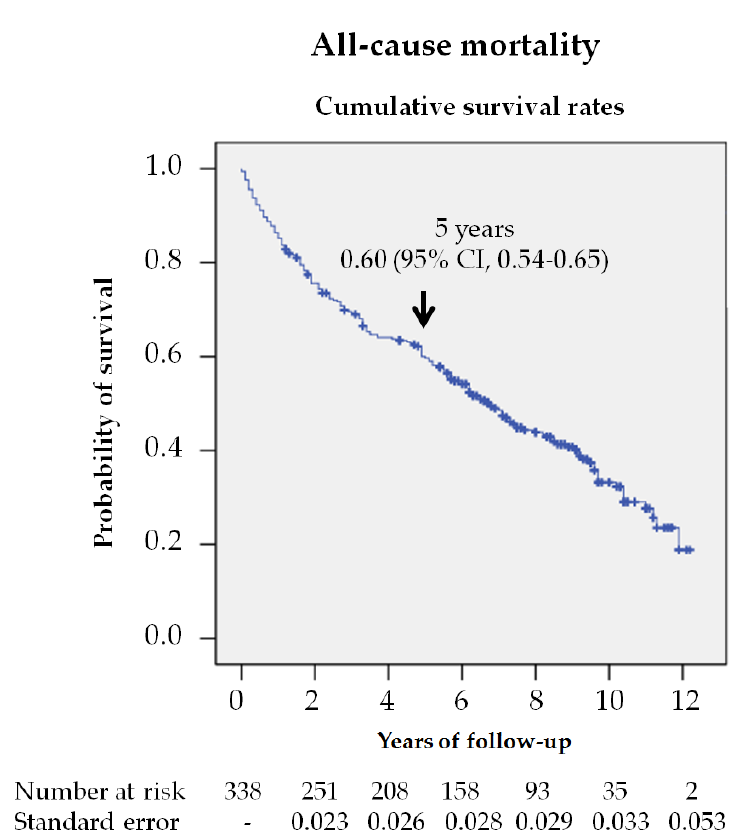
Figure 1. Survival analysis of the 338 patients with diabetic foot ulcers (DFU) from their first consultation at the MDFT center. The Kaplan—Meier curve shows the estimated 5-year survival rate.